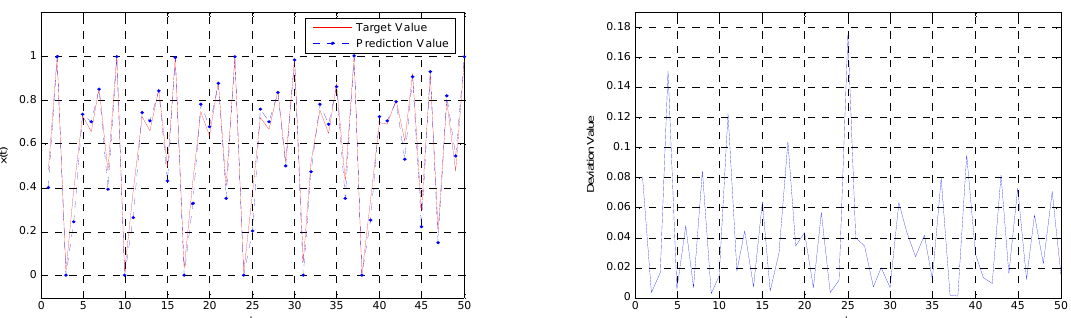
Fig. 18. The prediction value and the deviation value for Henon time